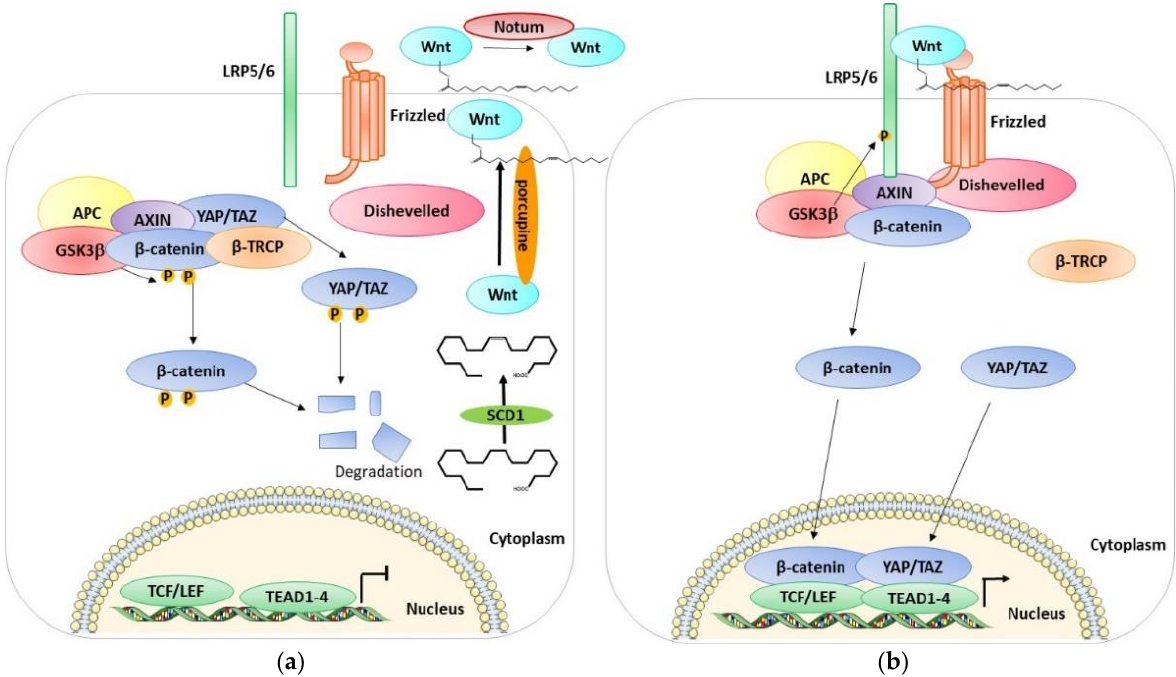
Figure 2. A schematic representation of the OFF and ON state of the Wnt pathway. ( a ) A scheme of the Wnt OFF state. The lack of Wnt ligands leads to the degradation of β -catenin, YAP/TAZ. Consequently, the level of β -catenin and YAP/TAZ in the cytoplasm is low, and they cannot enter the nucleus and activate their target genes. ( b ) A scheme of the Wnt ON state. Wnt ligands interacting with Frizzled inhibit the degradation of β -catenin and YAP/TAZ which accumulates in the cytoplasm and can enter the nucleus and interact with TCF/LEF and activate Wnt-responsive genes. See text for